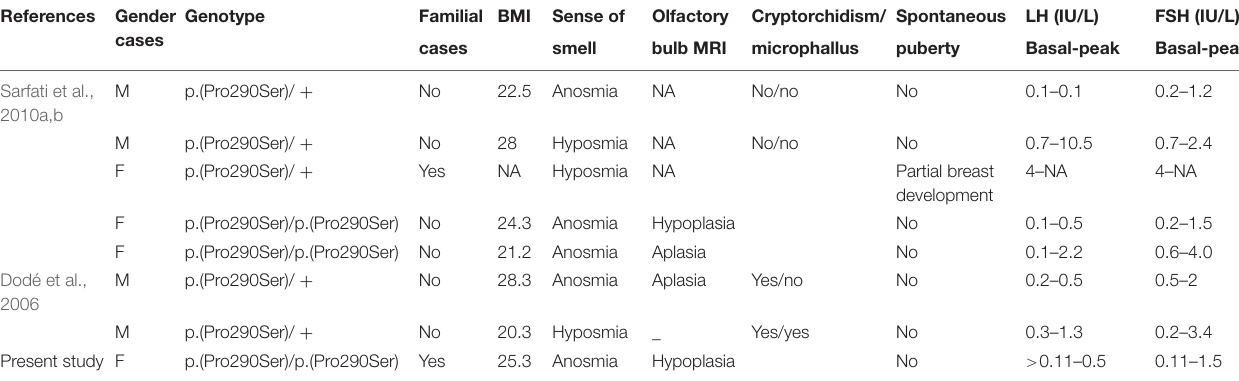
TABLE 4 | Clinical characteristics of patients having a monoallelic or a biallelic p.(Pro290Ser) mutation. References Gender cases